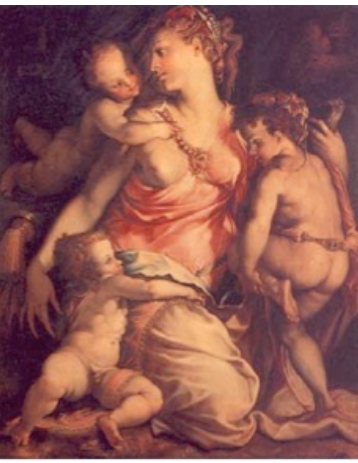
Fig. 2. Francesco Salviati, Charity, 1554-58. Oil on wood, 156 x 122 cm. Galleria degli Uffizi,